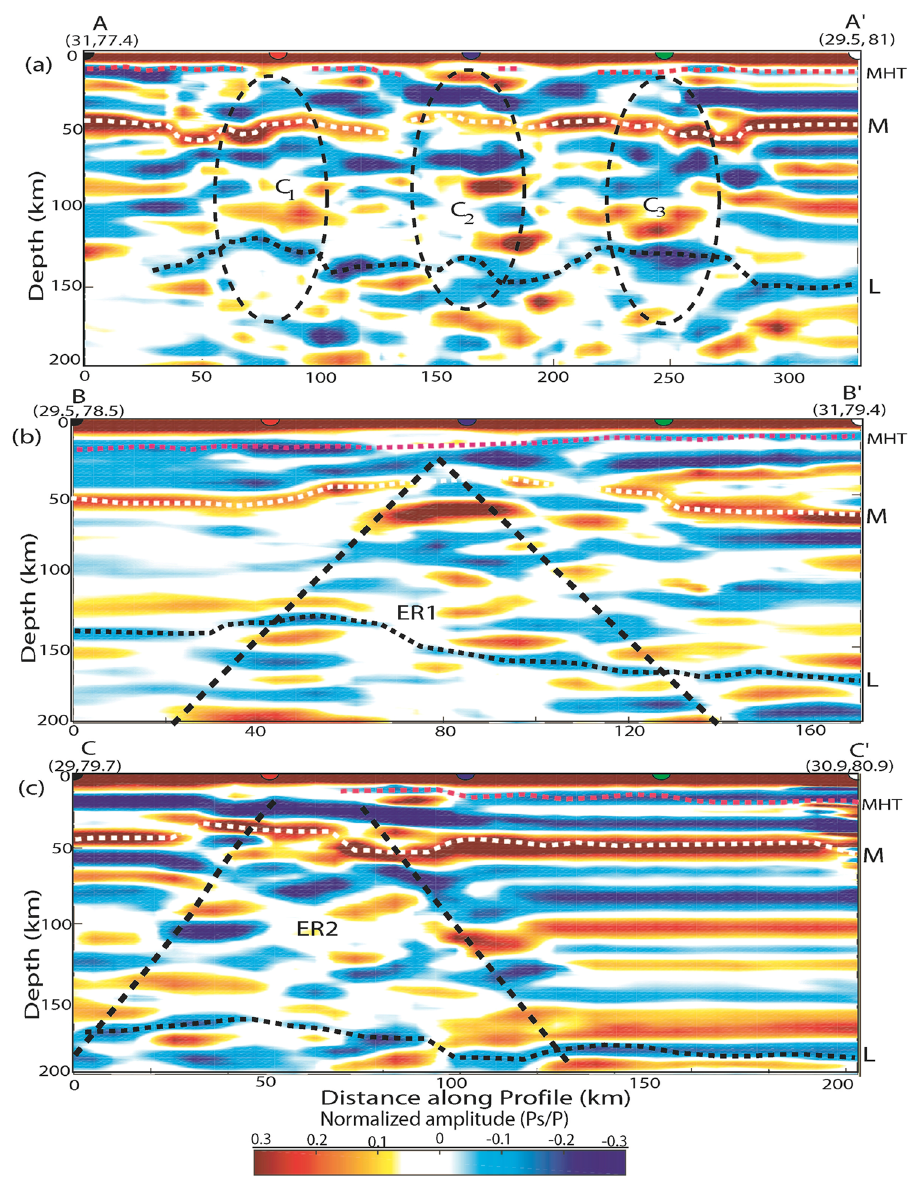
Figure 6. CCP stacking of PRFs using 1-D IASP91 velocity model along three profiles, whose locations are shown in Fig. 1a. Dotted lines show north dipping Main Himalayan Thrust (MHT), Moho and Lithosphere- Asthenosphere Boundary (LAB) below the Lesser Himalaya in the Uttarakhand Himalaya ( a ) AA’ profile, ( b ) BB’ profile and ( c ) CC’ profile. The locations of these profiles are shown in Fig. 1a. Black dotted elliptical areas mark the locations of mapped three lithospheric structures (C 1 , C 2 , and C 3 ), which are spatially correlating with the northward extension of the DHR, inferred tectonic boundary and GBF. Thick pink, white and black dotted lines mark the north dipping MHT, Moho and lithosphere. While inverted triangle shape areas (marked by very thick black dotted lines) represent the highly deformed and segmented crustal and lithospheric areas (ER1 and ER2) within the northward extension of the inferred tectonic boundary and GBF, respectively, which are transverse to the Himalayan collisional